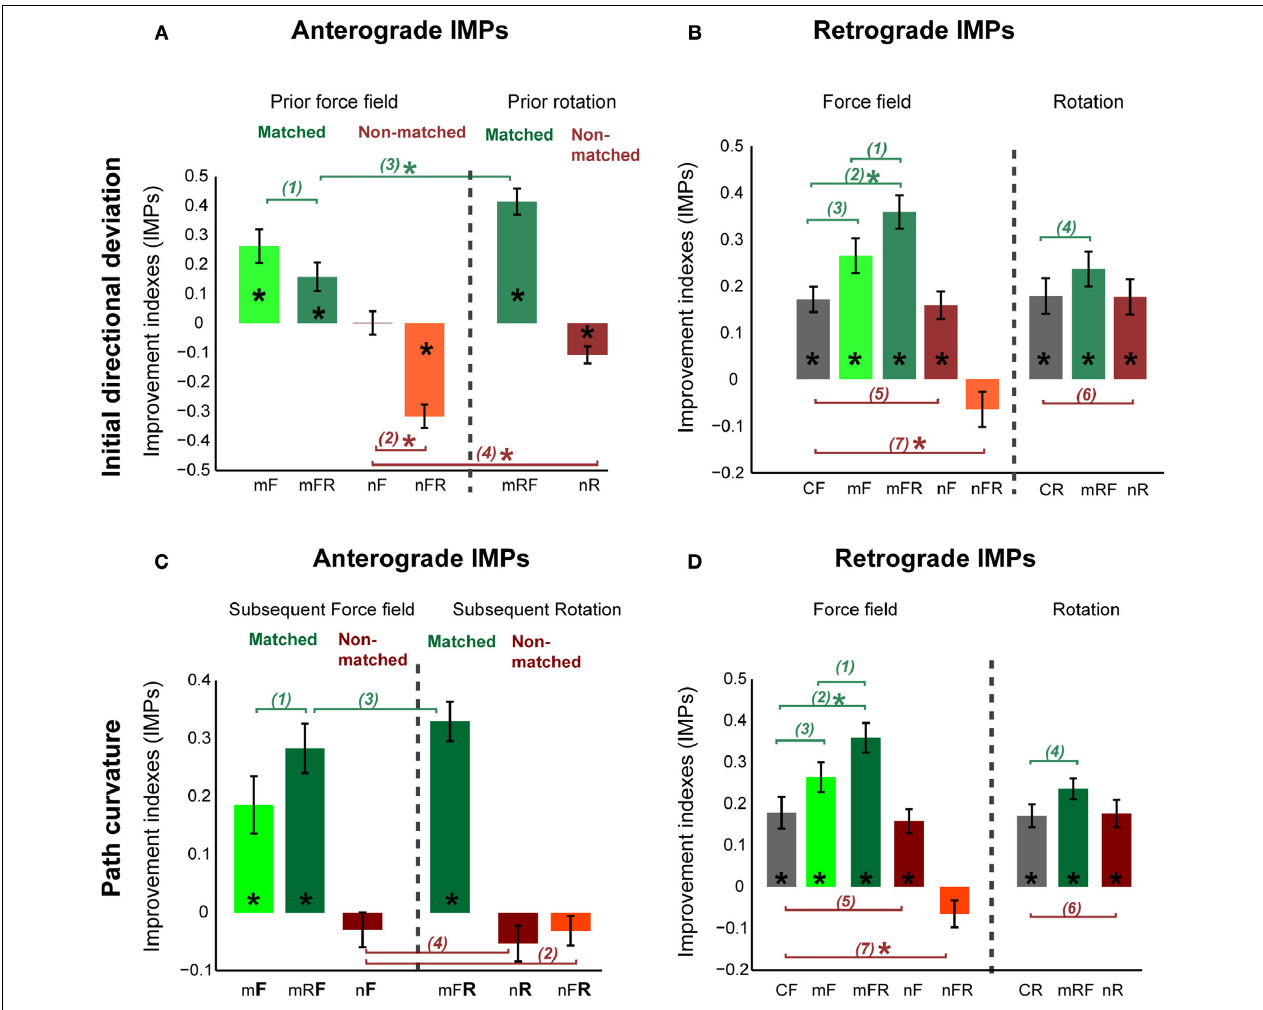
FIGURE 5 | Interaction effects between sequential adaptations. (A) Improvement indexes (IMPs) refl ecting anterograde effects of prior adaptation onto a subsequent adaptation to force fi eld (F) or rotation (R) of matched (m) or non-matched (n) direction. (B) Retrograde IMPs refl ecting degree of retention of the fi rst task learned in the sequence. IMPs from the control force (CF) and control rotation (CR) groups were also plotted (gray). Note